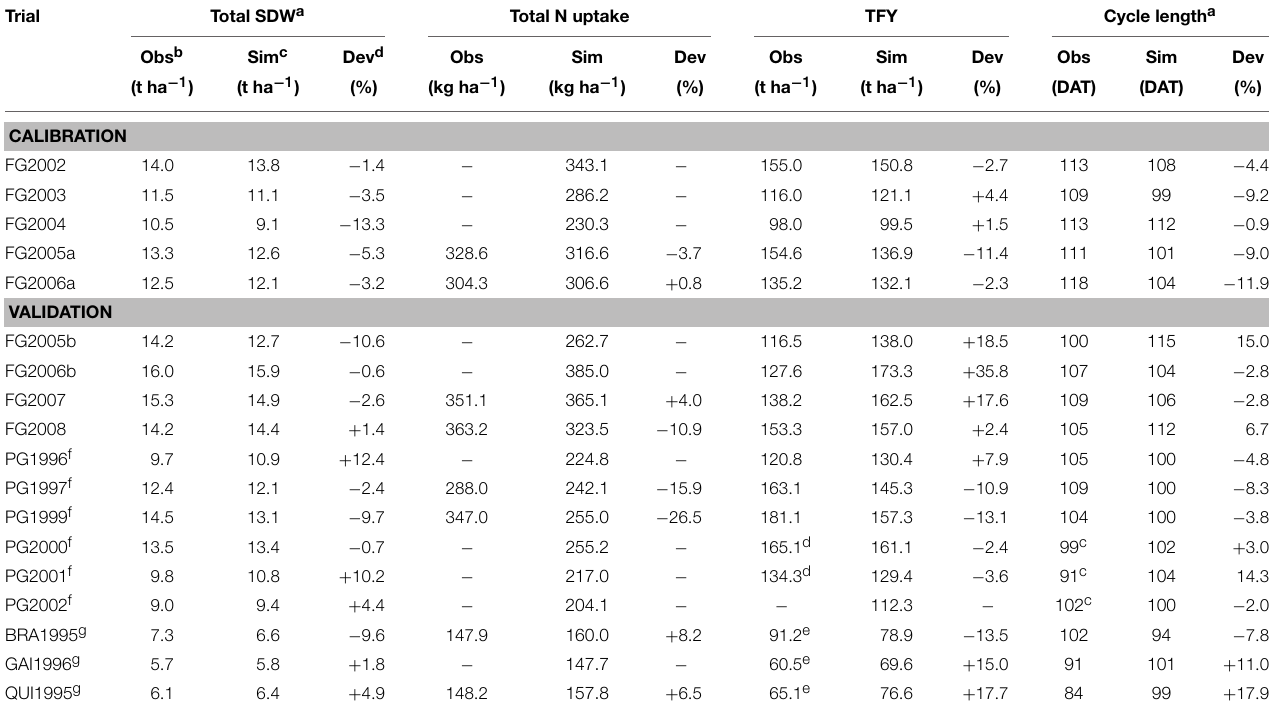
TABLE 5 | Differences between the simulated and the observed total shoot dry weight (SDW), total N crop uptake, total harvested fruit yield (TFY), and cycle length of field grown tomato in the five trials carried out from 2002 to 2006 in the Foggia area, used for calibrating GesCoN ., and in 13 trials from different years and locations (Foggia, Perugia, and Florida) used for validating GesCoN